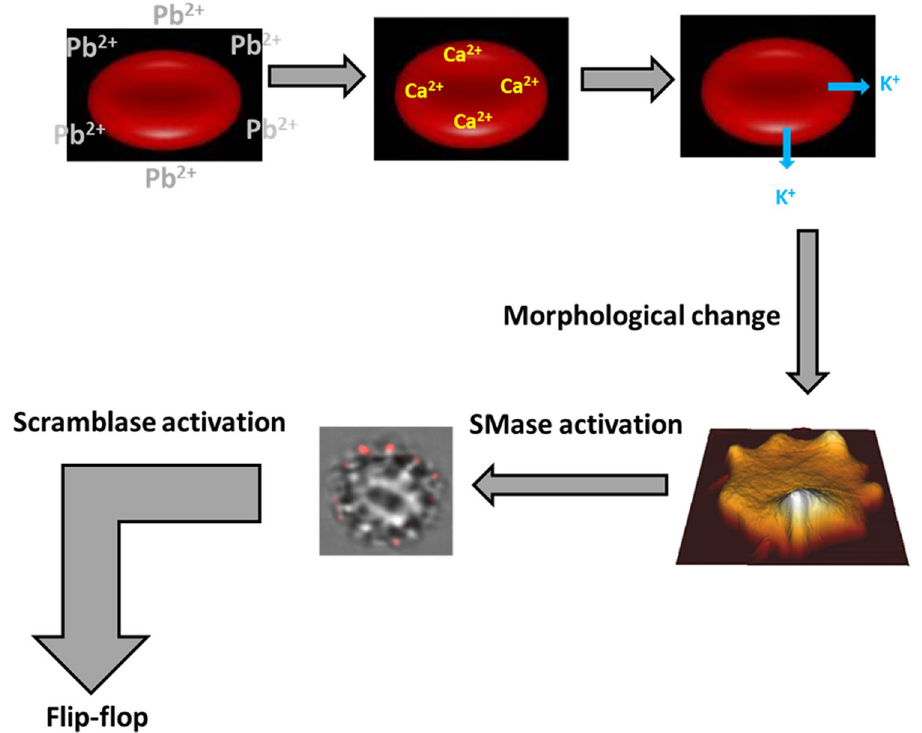
Figure 10. Pb 2 + -induced changes on RBC. General outline of the